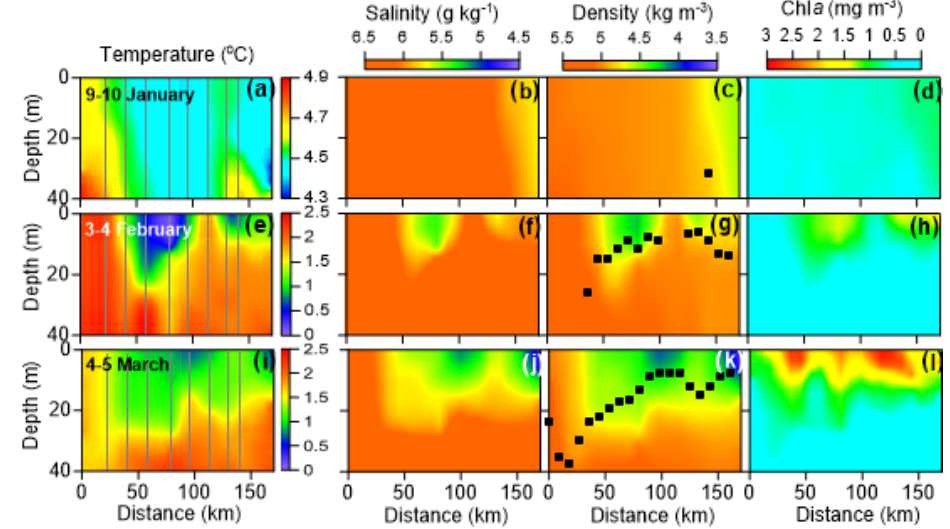
Figure 5. Vertical sections of temperature, salinity, density anomaly, and Chl a along a west-to-east profile in the Gulf of Finland (orange crosses in Fig. 1) in winter 2013/14. Vertical gray lines mark the location of CTD casts. Black dots on density anomaly panels mark the depth of the upper mixed layer. Deviating color scale for temperature on 9–10 January was